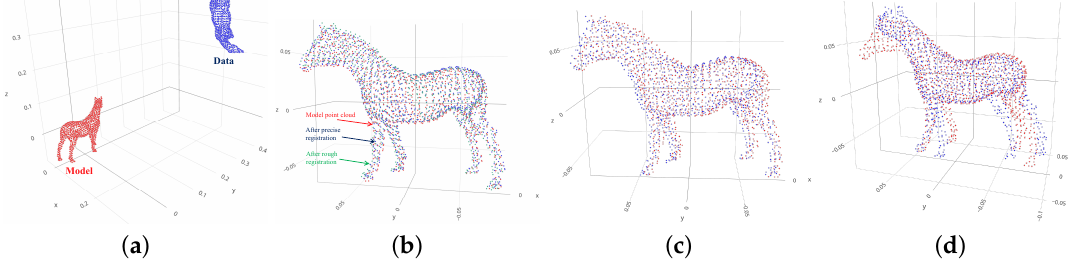
Figure 13. The registration results of Horse data for test sample 2: ( a ) The initial state; ( b ) 3-D CNNs then 2-D CNNs, ( c ) RANSAC then ICP, ( d ) Fast Global